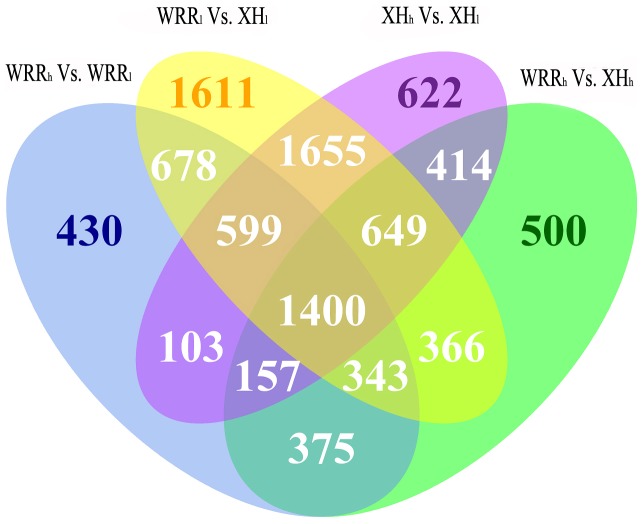
Differentially methylated genes unique or shared among four contrasts of WRRh Vs. WRRl, XHh Vs. XHl, WRRh Vs. XHh, and WRRl Vs. XHl.The number of differently methylated genes in each comparison was given at the top of each section of figures. WRRh Vs. WRRl indicated the comparison between the two-tail samples of Recessive White Rock. XHh Vs. XHl indicated the comparison between the two-tail samples of Xinhua Chickens. WRRh Vs. XHh indicated the comparison between the groups of Recessive White Rock and Xinhua Chickens with high body weight. WRRl Vs. XHl indicated the comparison between the groups of Recessive White Rock and Xinhua Chickens with low body weight.